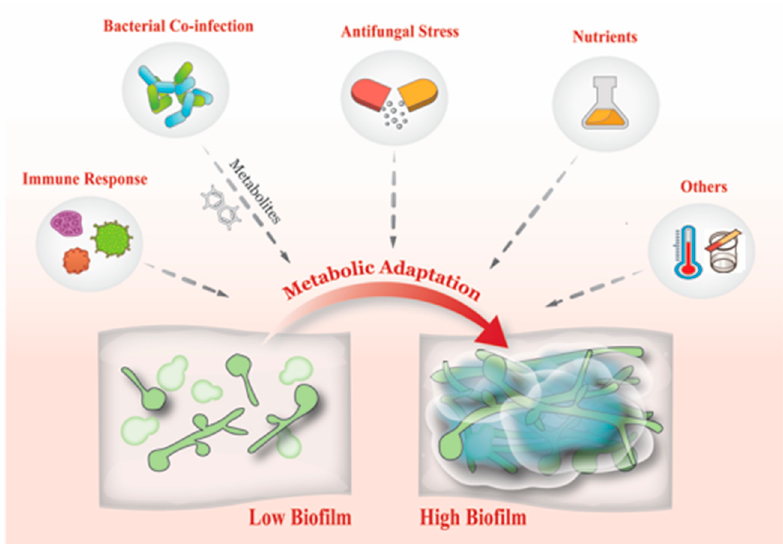
Figure 1. Factors influencing biofilm formation. There are multiple stimuli that can induce biofilm formation including the immune response, antifungal stress, and bacterial derived metabolites. Environmental stressors can also stimulate biofilm formation, and these include the availability of nutrients, temperature, and pH. Dashed arrows represent different factors that associate with biofilm formation.